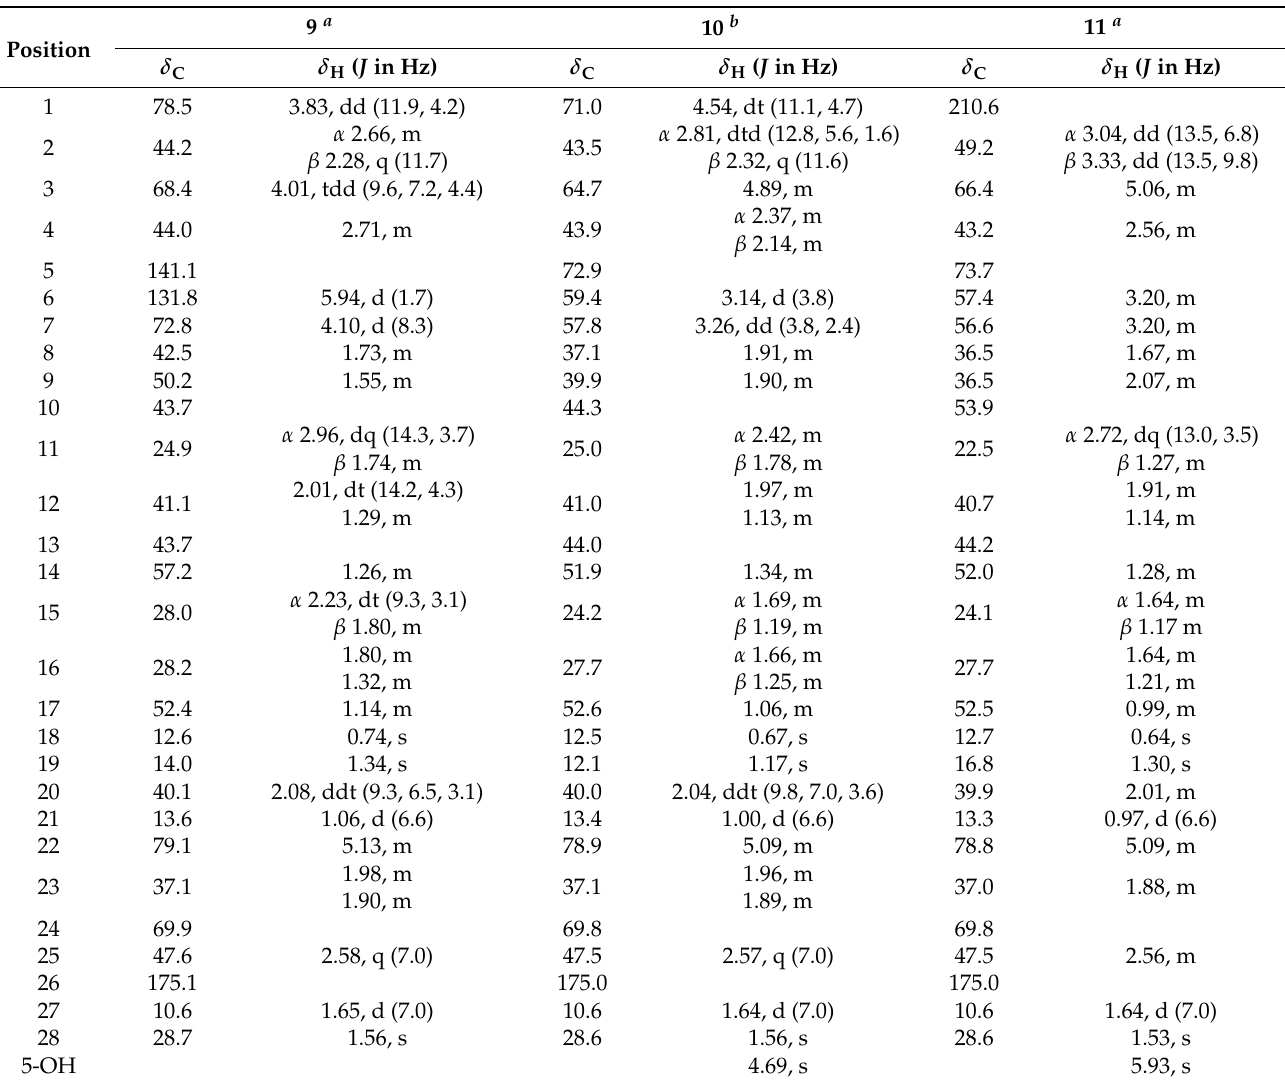
Table 3. 1 H and 13 C NMR data for compounds 9 – 11 ( δ in ppm, J in Hz, in pyridine- d 5